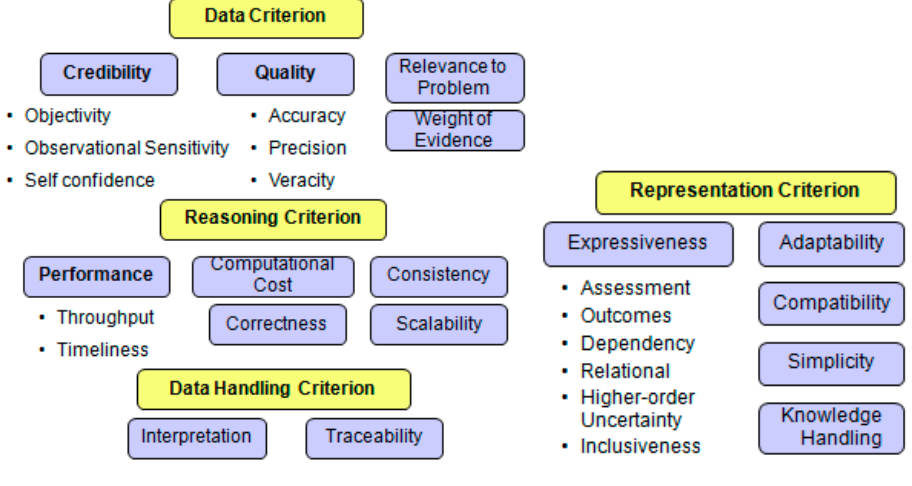
Figure 1. URREF Categories.